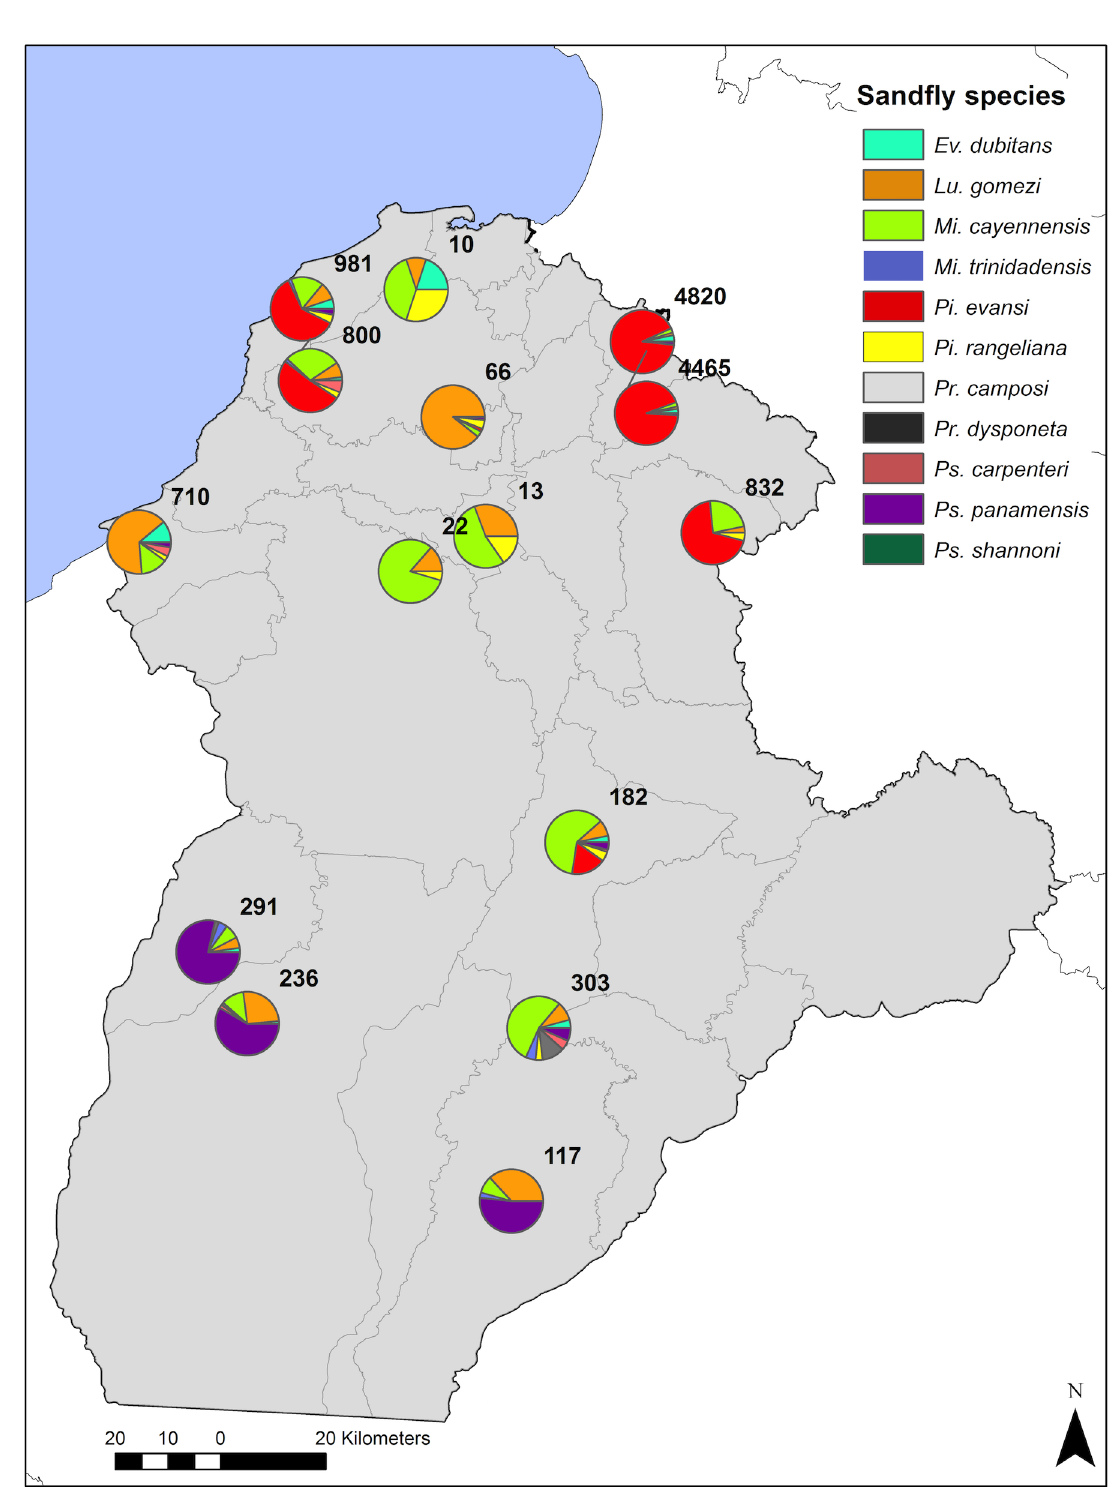
Fig 2. Sand fly species diversity and community composition in each of the 15 sampled localities in the Cordoba department in Colombia. Diversity was computed as total number of sand flies captured by locality (grouped from 24 houses, sampled both intra and peridomiciliary). Different colors represent different species of sand flies identified with traditional morphological techniques and confirmed via DNA barcoding.